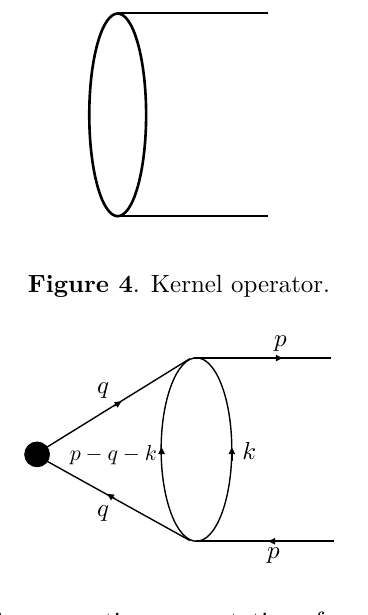
Figure 5 . Diagrammatic representation of equation